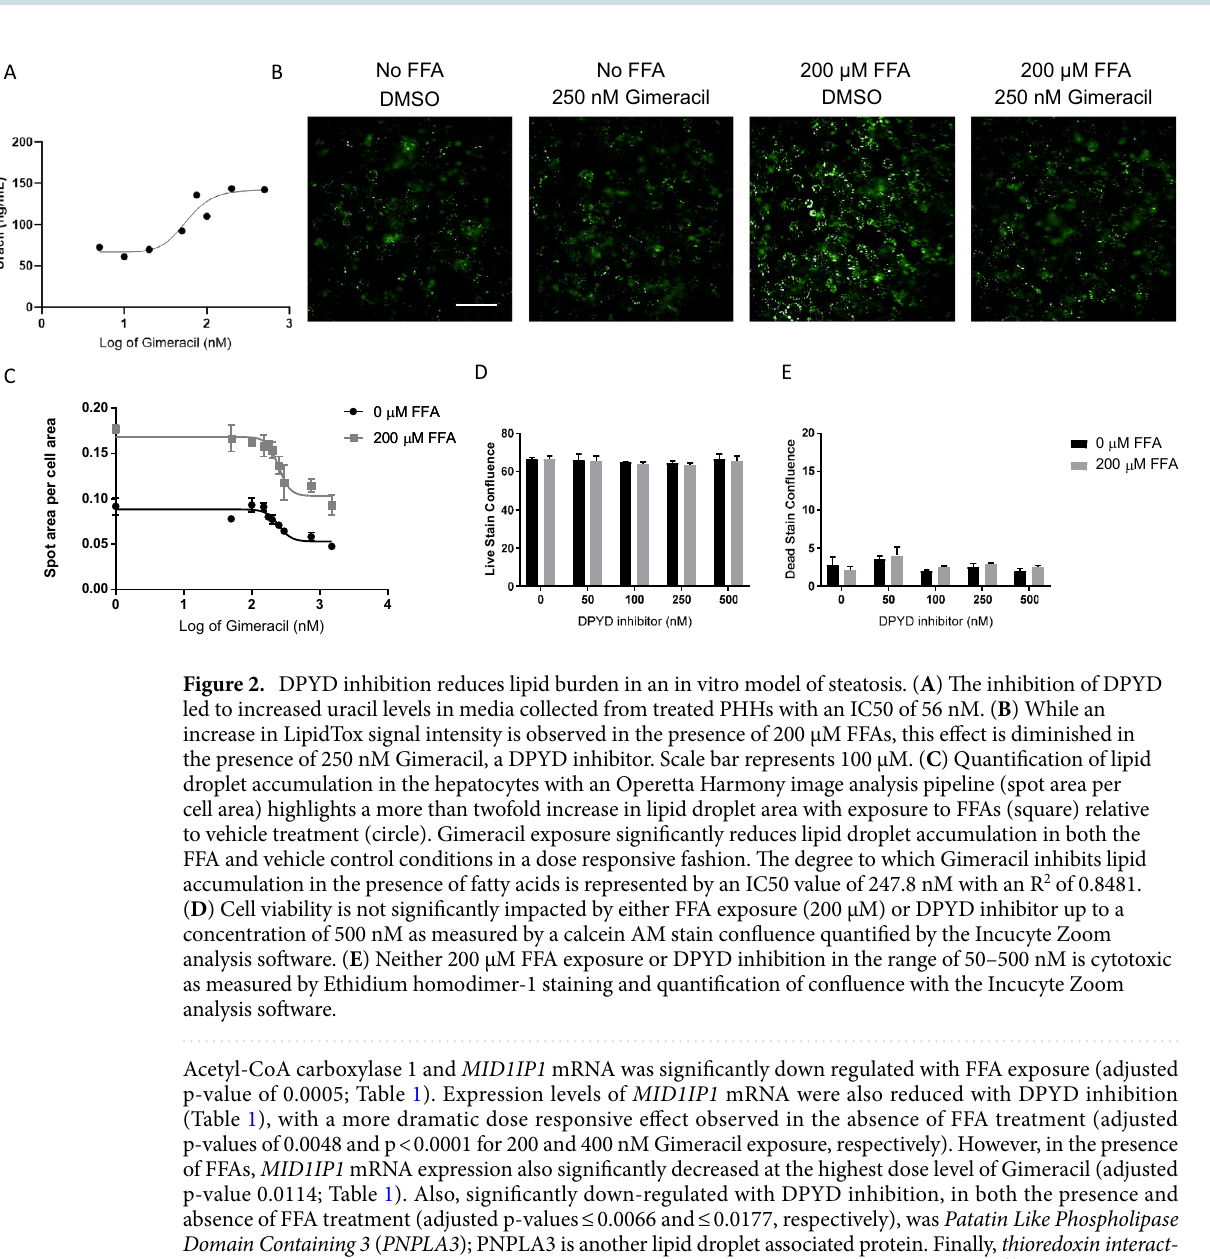
(Table 1), with a more dramatic dose responsive effect observed in the absence of FFA treatment (adjusted p-values of 0.0048 and p < 0.0001 for 200 and 400 nM Gimeracil exposure, respectively). However, in the presence of FFAs, MID1IP1 mRNA expression also significantly decreased at the highest dose level of Gimeracil (adjusted p-value 0.0114; Table 1). Also, significantly down-regulated with DPYD inhibition, in both the presence and absence of FFA treatment (adjusted p-values ≤ 0.0066 and ≤ 0.0177, respectively), was Patatin Like Phospholipase Domain Containing 3 ( PNPLA3 ); PNPLA3 is another lipid droplet associated protein. Finally, thioredoxin interact- ing protein 1 (TXNIP ) mRNA expression, a critical regulator of hepatic glucose production 20 , was significantly reduced as a function of Gimeracil treatment in the presence and absence of FFAs (adjusted p-values ≤ 0.0017 and 0.0101, respectively). Taken together, these results demonstrate the significant effect of Gimeracil on altering the metabolic profile of hepatocytes at the transcript level. To help characterize the functions of DPYD variants, DPYD mutant forms were generated by site directed mutagenesis. As protein degradation was observed for both wild type and L310S mutant forms of DPYD, the concentration of the active protein was calculated based on the intensity of the ~ 130 kDa band as a fraction of the total intensity of all bands on SDS-PAGE (Fig. 5A). The active protein concentrations were used for the determination of kinetic parameters of DPYD. The kinetic measurements of DPYD were carried out by varying concentrations of uracil. The obtained data fit best with a substrate inhibition model, yielding k cat values of 65 ± 4 and 99 ± 5 min −1 for wild type and L310S mutant forms of DPYD (Fig. 5B). Screening of hepatocarcinoma cell lines based on their expression levels of both UPP1 and DPYD mRNA transcript demonstrated that the SNU449 cell line had the optimal mRNA expression levels of both enzymes as measured by their relative ratio of 1, whereas PHHs demonstrated a ratio of 1.1 (Fig. 6A). This cell line responded to FFA exposure with an increase in lipid content and Gimeracil treatment significantly reduced lipid accumu- lation in a dose-responsive manner as well (R 2 = 0.8560 and IC50 of 19.74 nM) (Fig. 6B,C). Next-Generation sequencing revealed successful generation of a homozygous L310S DPYD mutant line and a homozygous, PAM- edit only, control line through homology directed repair (Fig. 7). In addition, employing NHEJ methodology, a heterozygous knock-out mutant line was generated with allele A possessing a D308_F309delinsV mutation and allele B possessing a S306_K307_delinsL* mutation. PROVEAN predicted allele A would be functionally